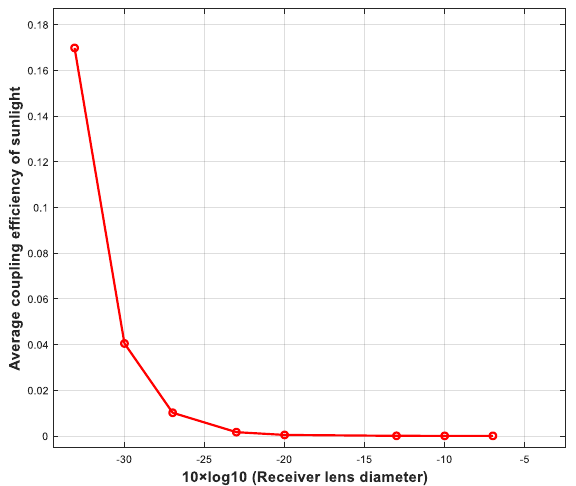
Figure 10. Curve of average coupling efficiency of sunlight vs. receiver lens diameter (receiver lens diameter with unit of meter).